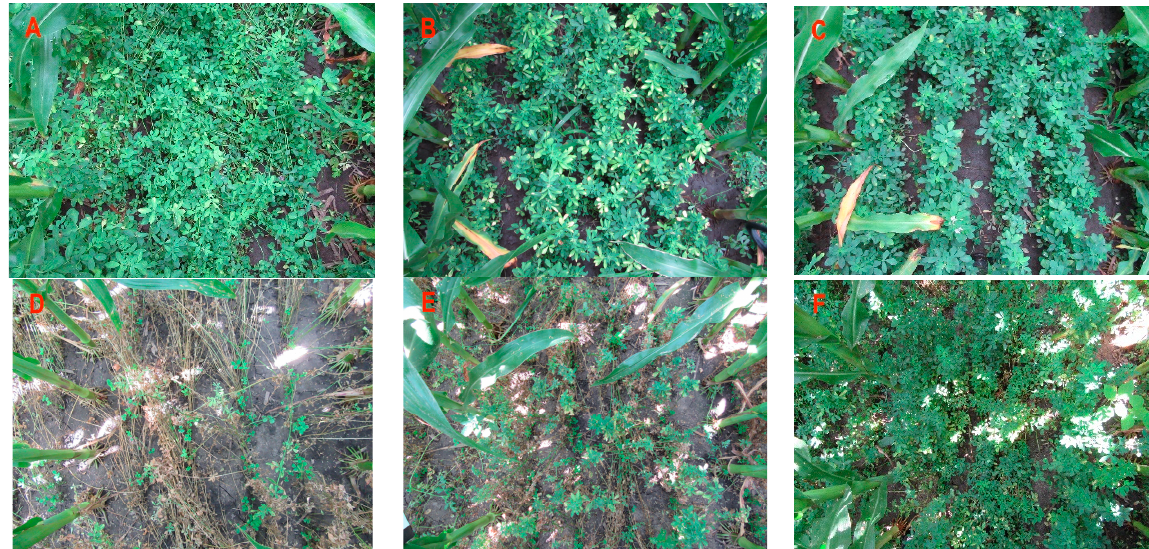
Figure 4. Defoliation of alfalfa four weeks after fungicide and insecticide application as affected by corn population and agrichemical treatments. Agrichemical treatments applied to alfalfa during establishment consisted of a nontreated con- trol, prohexadione (PHD), and prohexadione, followed by fungicide and insecticide (PHD-FI). Data were averaged across alfalfa varieties and production years. Regression intercepts and slopes differed between agrichemical treatments ( p = 0.05).